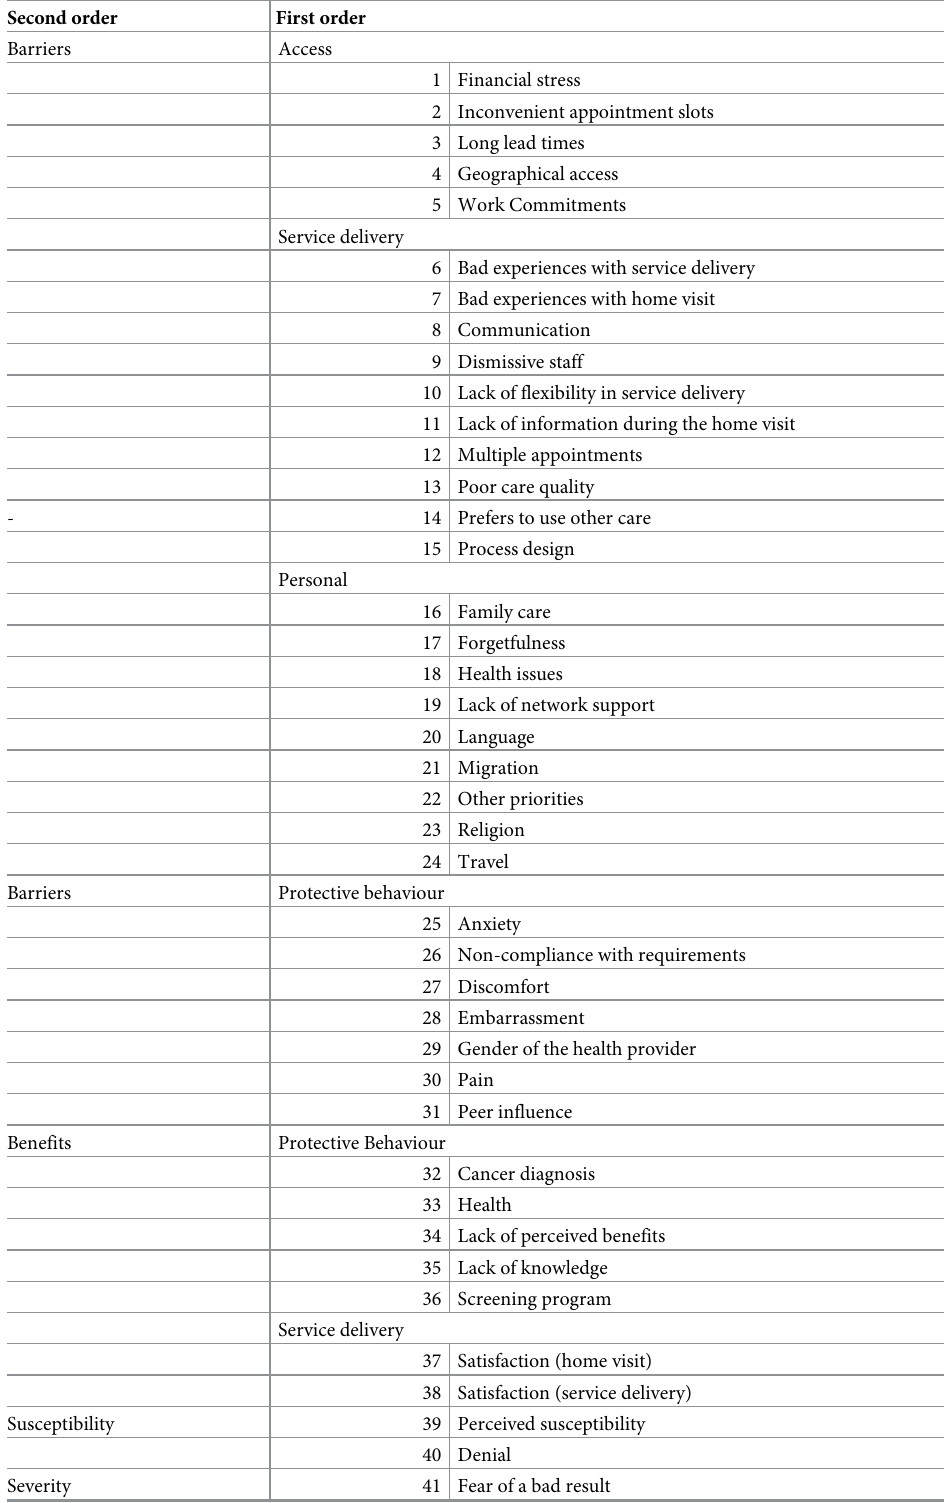
Table 3. Analytical framework